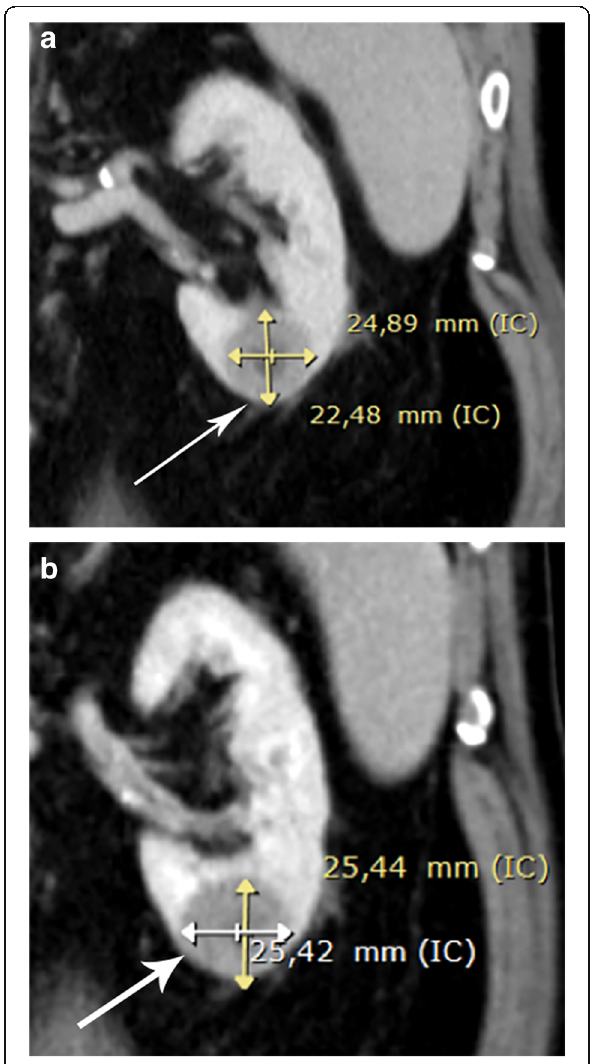
Fig. 11 Calculation of the linear growth rate (GR) of a lower third left kidney small renal mass (SRM) undergoing active surveillance (AS) in a 65-year-old patient (arrows). a Coronal contrast-enhanced CT of the renal mass showing an axial MTD of 2.5 cm (24.89 mm) at the beginning of the surveillance and ( b ) 3 which had only increased to 2.5 cm (25.44) 3 years later. With the use of the linear GR formula in centimeters, 2.5 cm − 2.5 cm = 0 cm divided by 36 months and multiplied by 12, the annual GR was shown to be 0 cm/ year, indicating that the renal mass was stable. After 5 years of follow-up, the interval between imaging tests can be lengthened or even discontinued according to the decision of the multidisciplinary